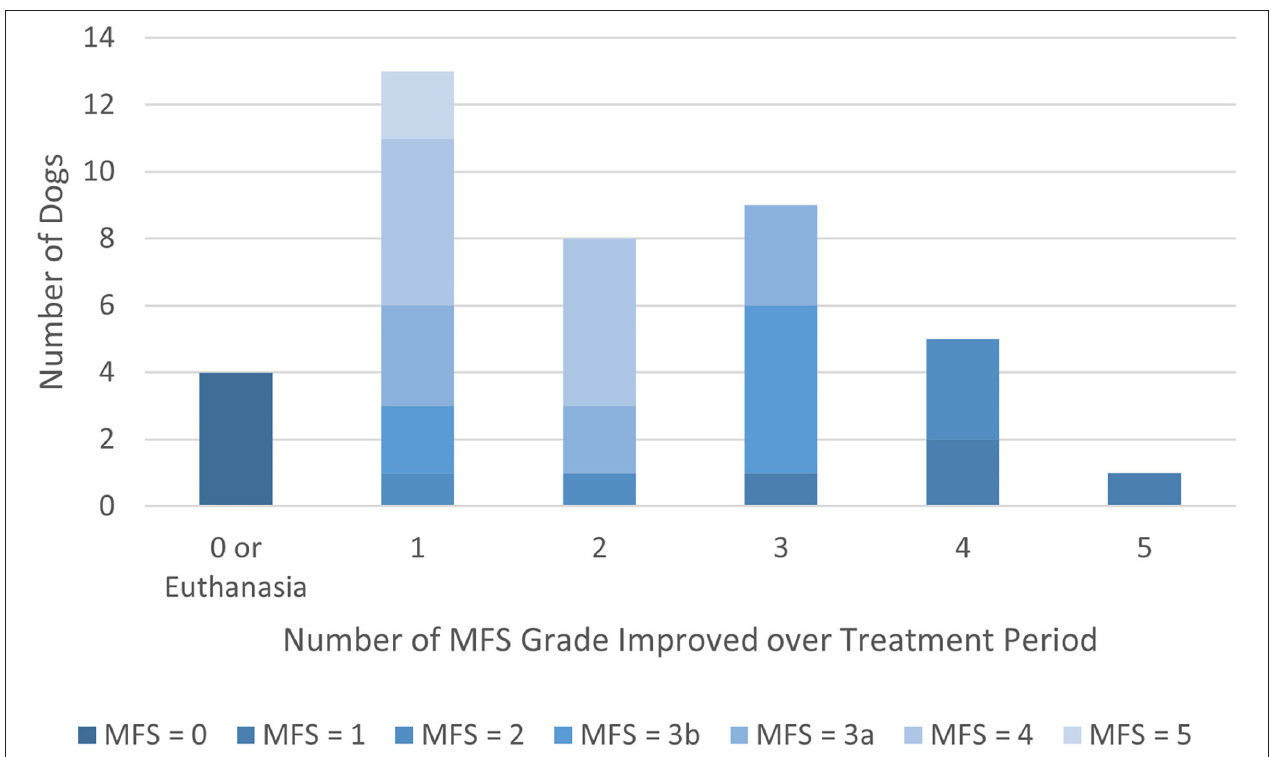
FIGURE 1 | Modified Frankel Score (MFS) grade improvement over treatment period by MFS score at presentation. Shading designates the MFS score at